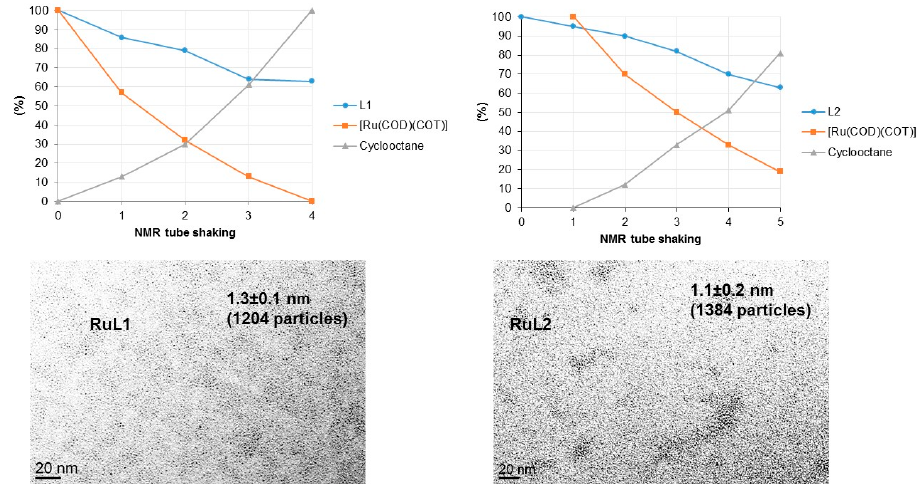
Figure 3. Graphical representations of the data corresponding to the consumption of ligand and [Ru(COD)(COT)], and formation of cyclooctane ( top ); TEM images of RuL1 and RuL2 after total consumption of [Ru(COD)(COT)] ( bottom ).